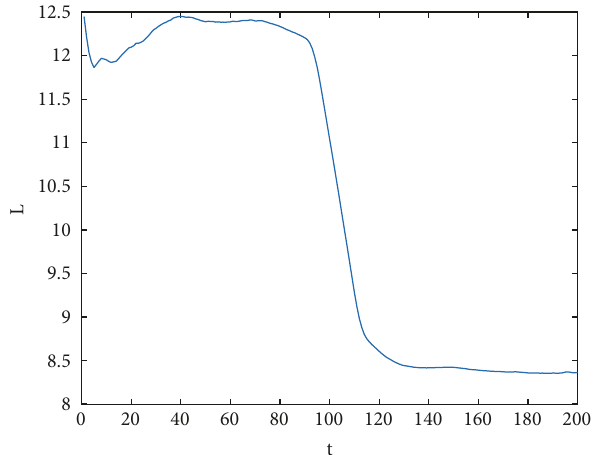
Figure 5: The evolution picture of the collaborative innovation network average path